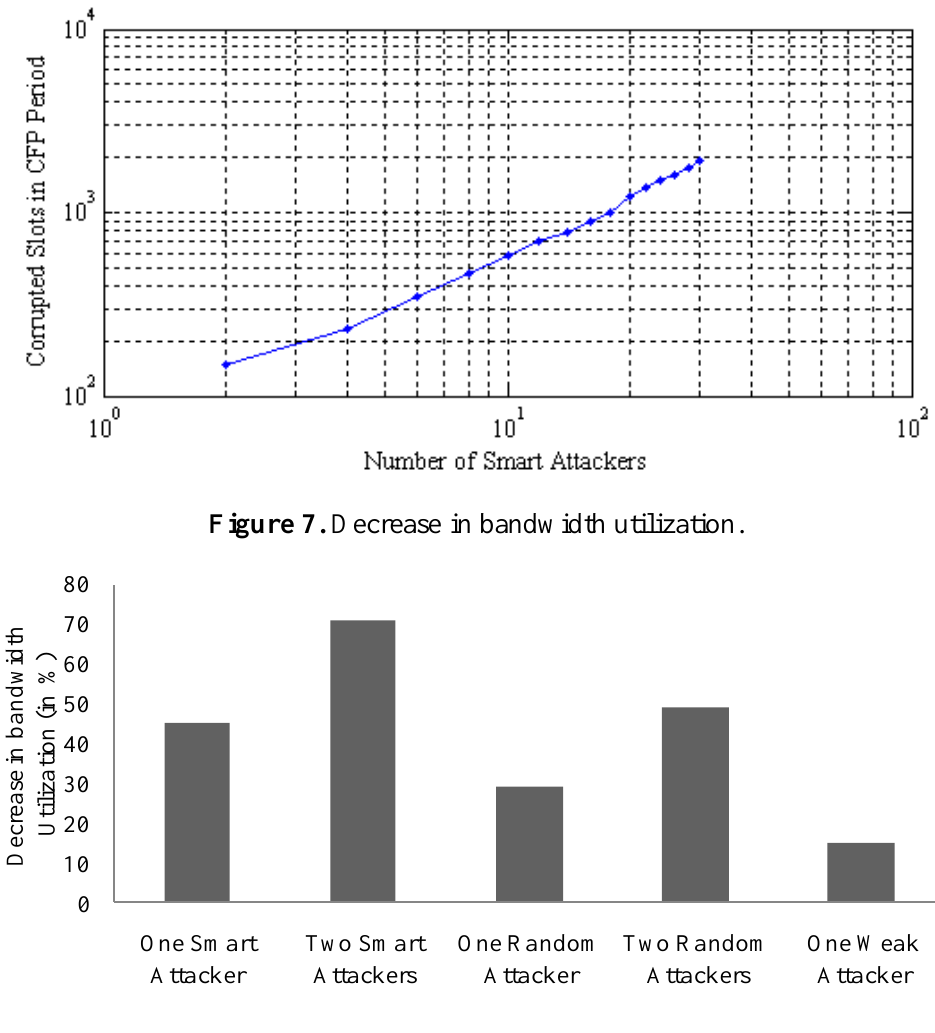
Figure 6. Total number of corrupted slots in the CFP.